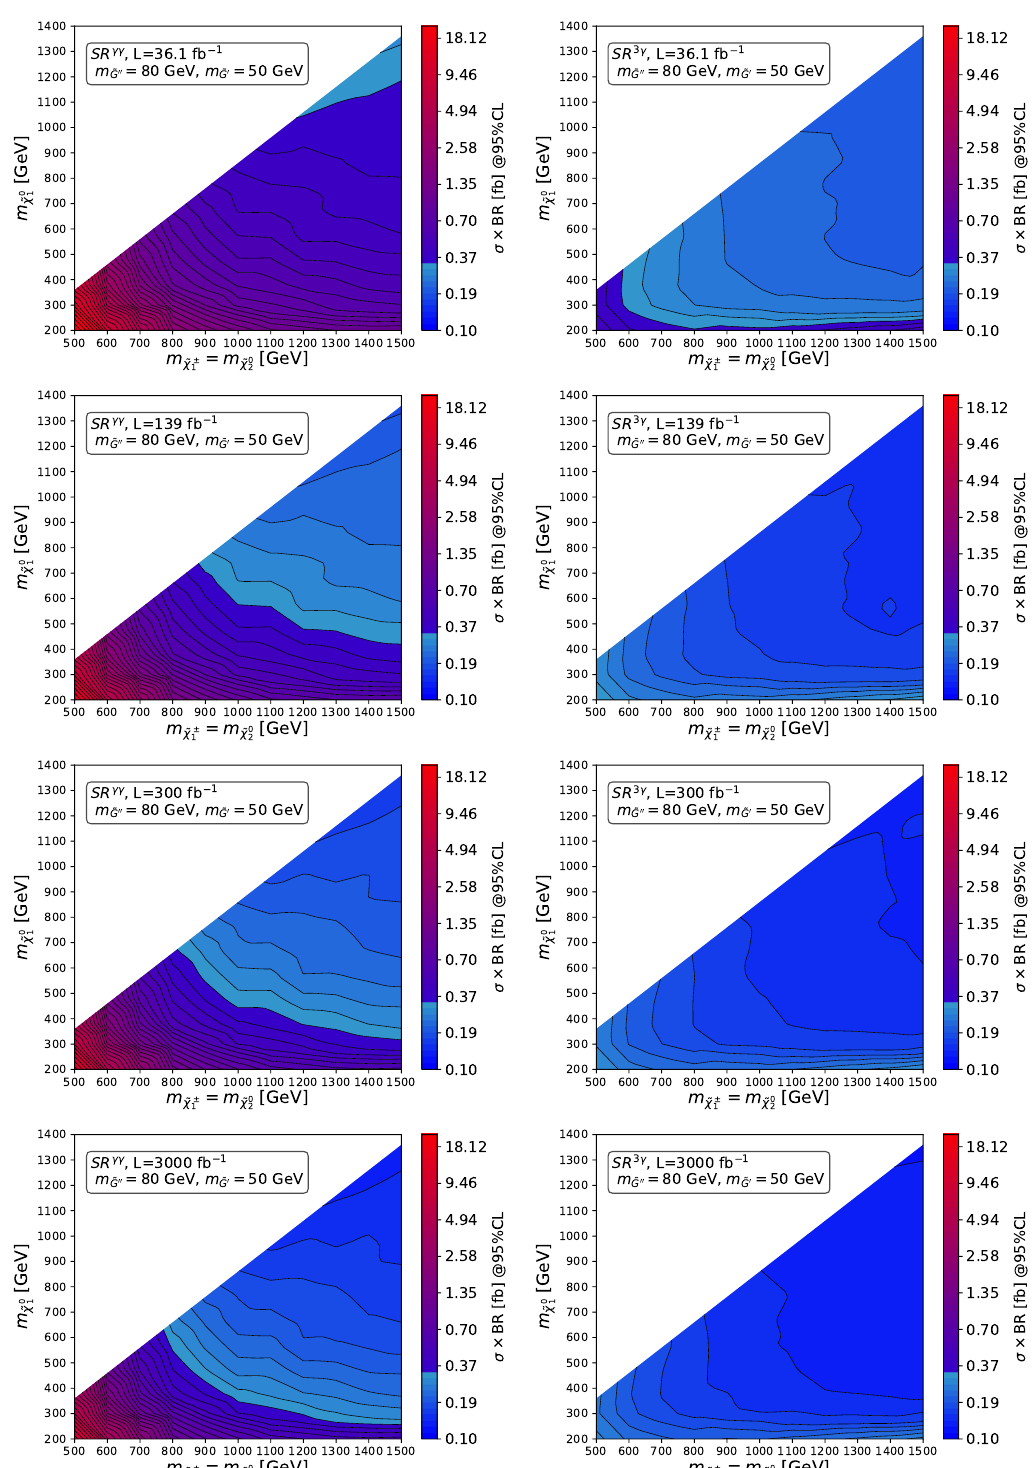
Figure 4 . The upper limit at 95% C.L. on the production cross section times branching ratio (in fb) in the chargino-neutralino grid from SR γγ (left) and SR 3 γ (right). The rows correspond to integrated luminosities of L = 36 . 1 fb − 1 , 139 fb − 1 , 300 fb − 1 and 3000 fb − 1